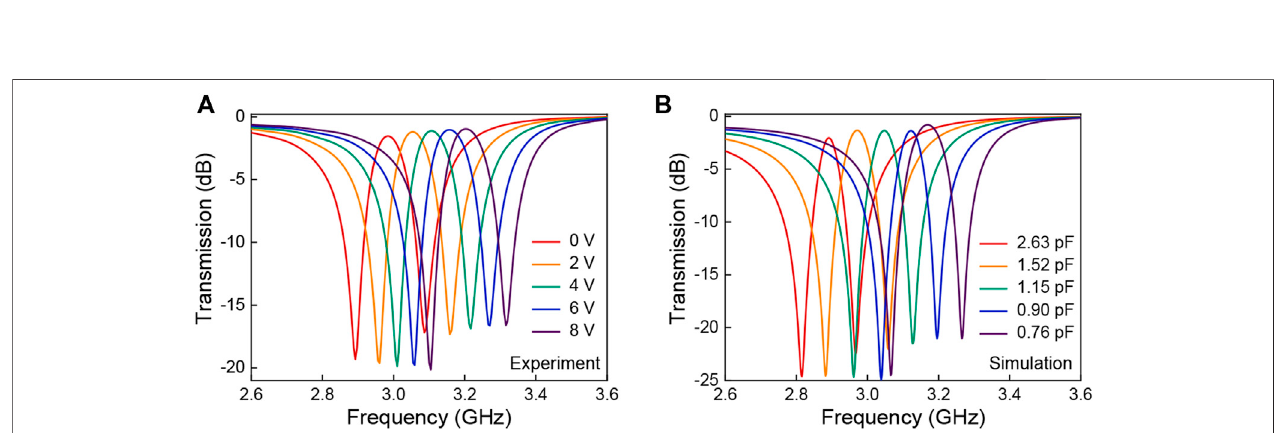
FIGURE6| Measured (A) andcalculated (B) transmissionspectraofthefrequency-agilemetasurfacewithdifferentbiasvoltages(from0to8 V)andcorresponding capacitances (from 2.63 to 0.76 pF).